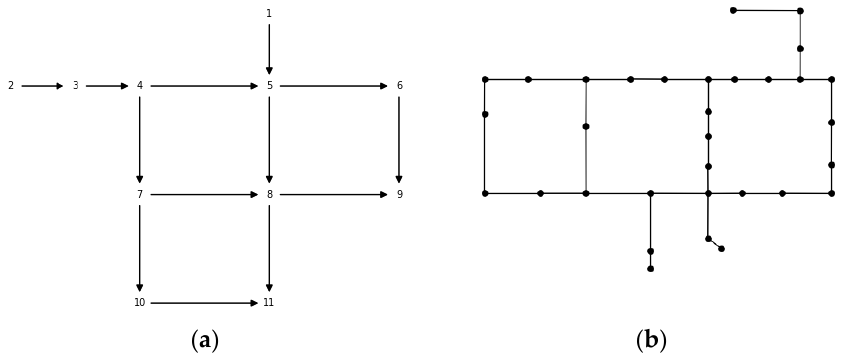
Figure 4. The graph of Net1 ( a ) and Hanoi ( b